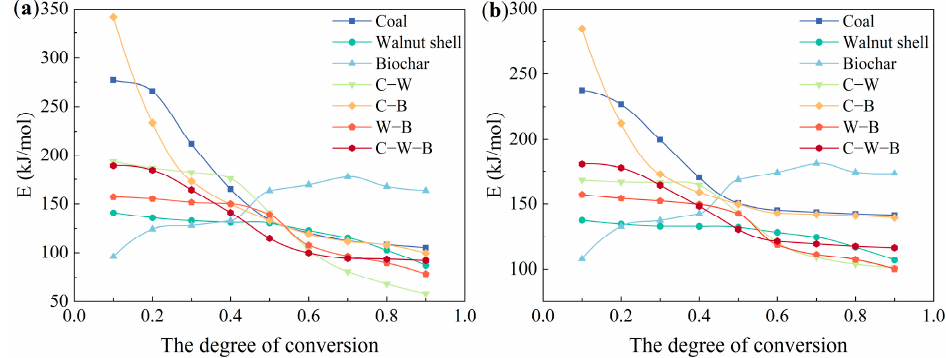
Figure 6. Apparent activation energy of the samples tested under each conversion: ( a ) KAS; ( b )